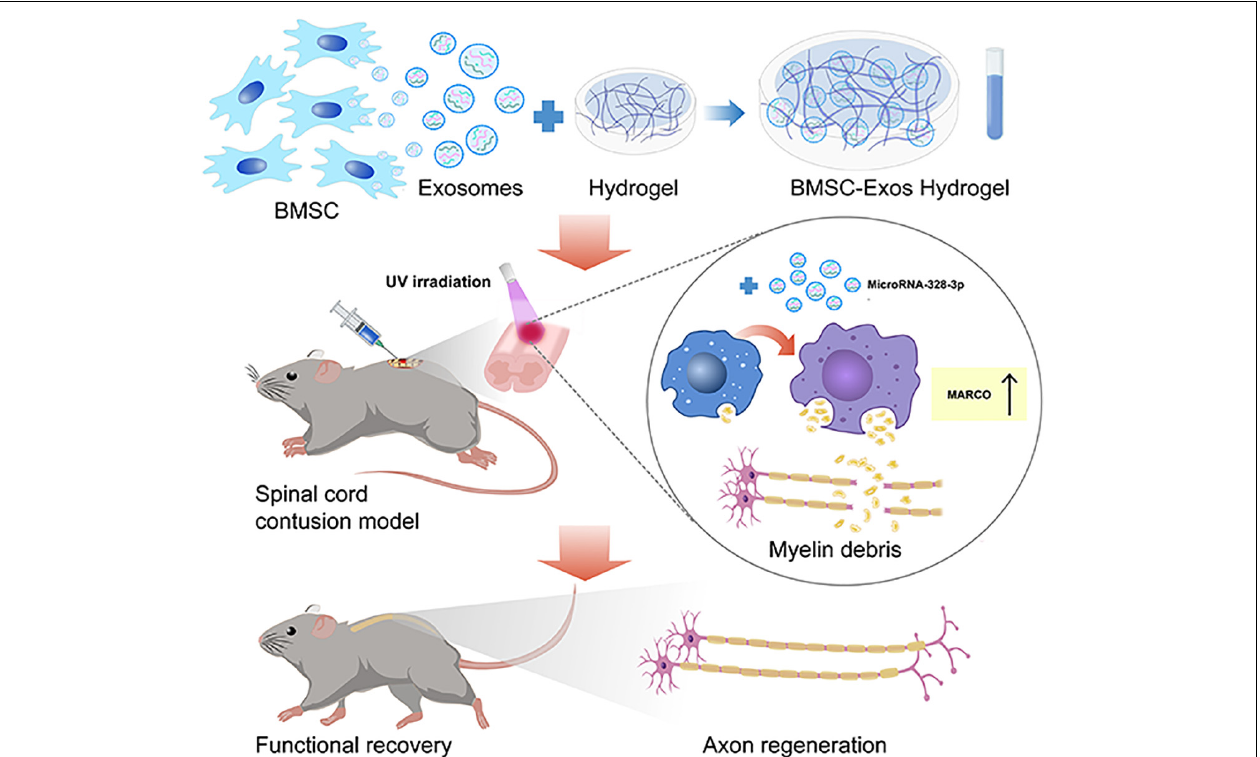
FIGURE 10 | The schematic diagram depicts that the administration of bone marrow mesenchymal stem cell-derived exosomes (BMSC-Exos) mixed with hydrogel are transplanted to the surface of the injured spinal cord that could rescue normal macrophage function to clean myelin debris, creating a pro-regenerative environment that aided axon regeneration and neurological functional restoration after spinal cord injury (SCI). This process was mediated by upregulating the expression of macrophage receptor with collagenous structure (MARCO) in macrophages.